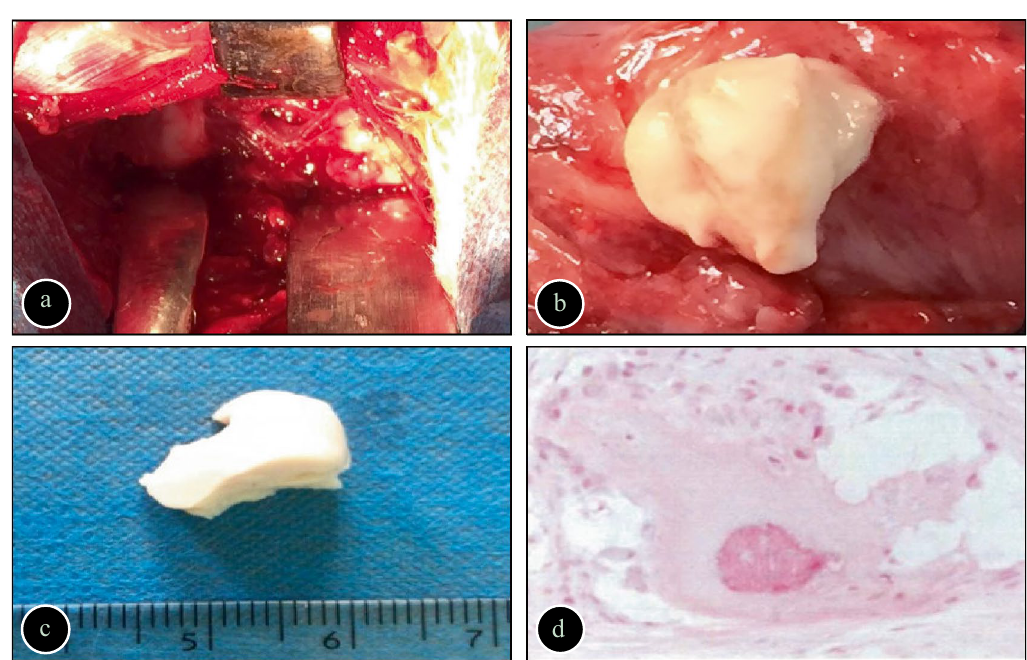
Figure 3. ( a ) A spinal tuberculosis lesion (vertebral bone destruction and paravertebral abscesses could be seen); ( b ) Abscess formation; ( c ) Caseous necrotic substance; ( d ) Bone depressions within the affected vertebrae, and fibrous tissue around the